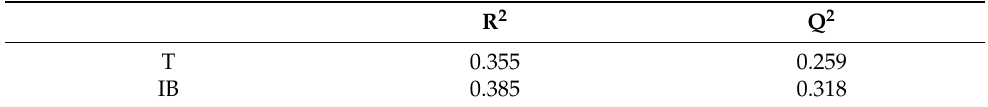
Table 5. Structural model